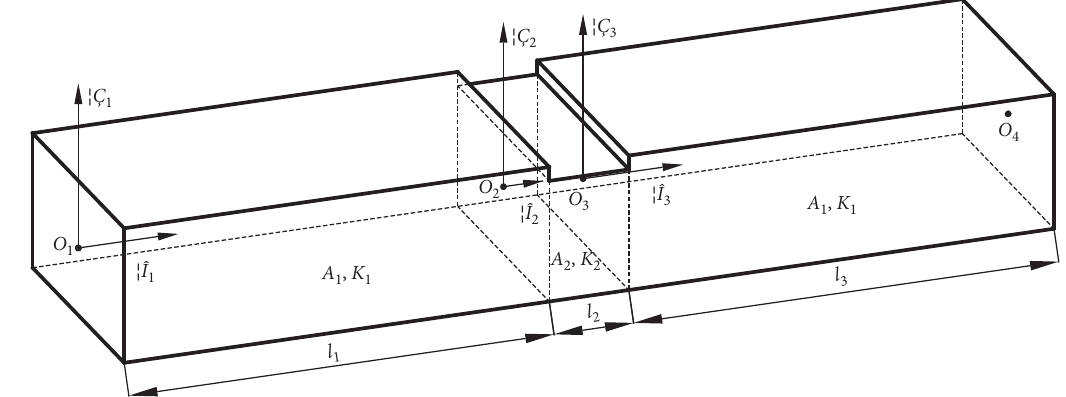
Figure 2: Geometrical nondimensional parameters of the notched